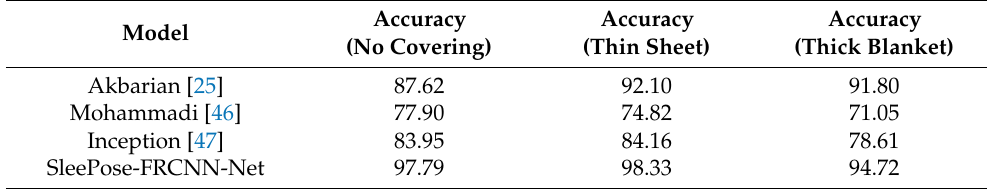
Table 12. Results of upper-body pose classification on the iSP pilot